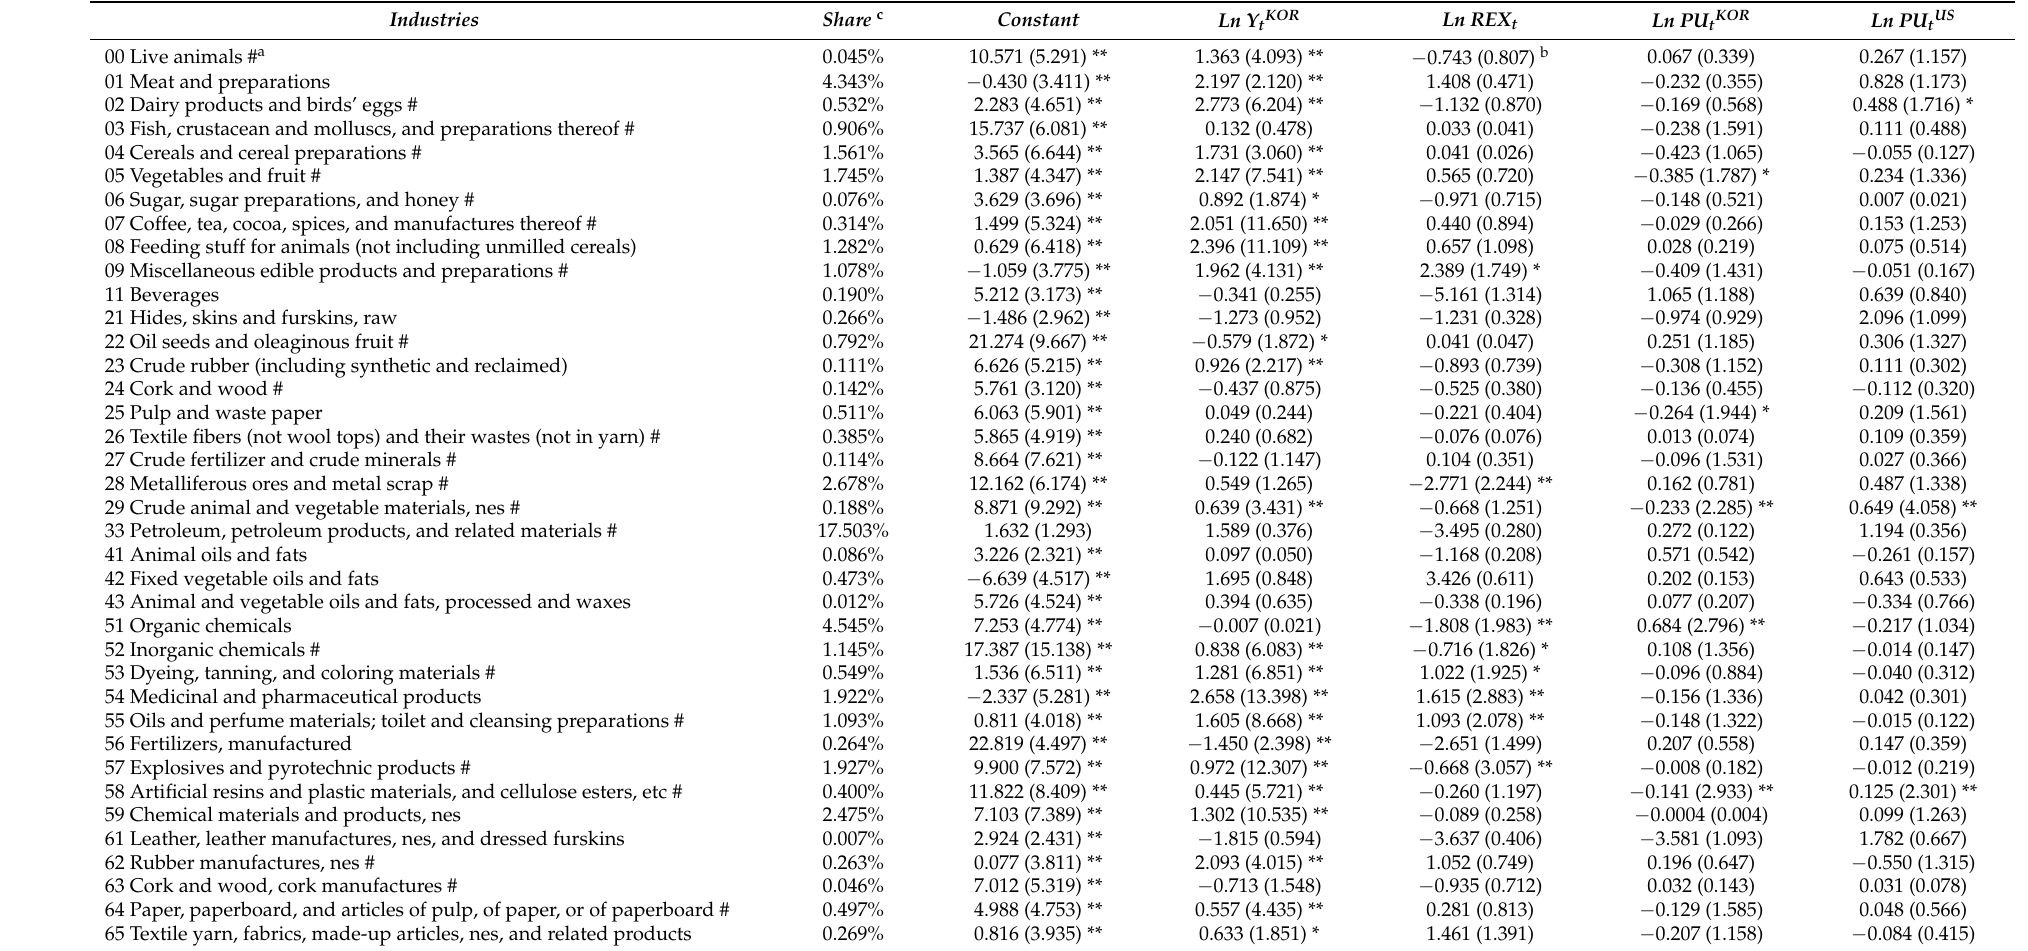
Table 3. Long-run coefficient estimates of U.S. export